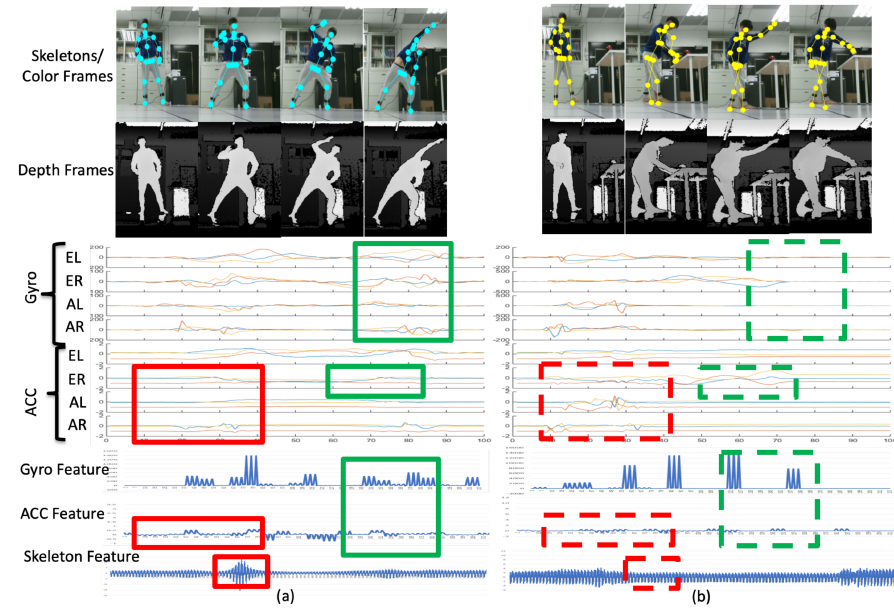
Figure 17. Representations of ( a ) the left-stretch motion and ( b ) the coffee-pouring